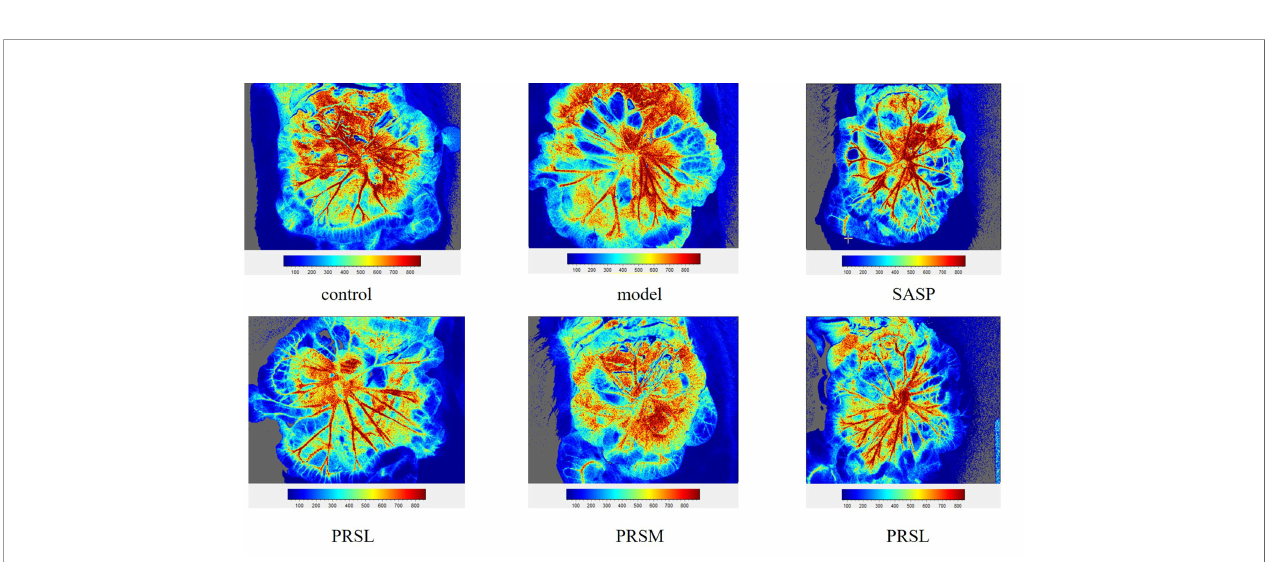
FIGURE 6 | Mesenteric blood fl ow volume of each group of rat. Data are presented as means ± SD (n= 6 per group).